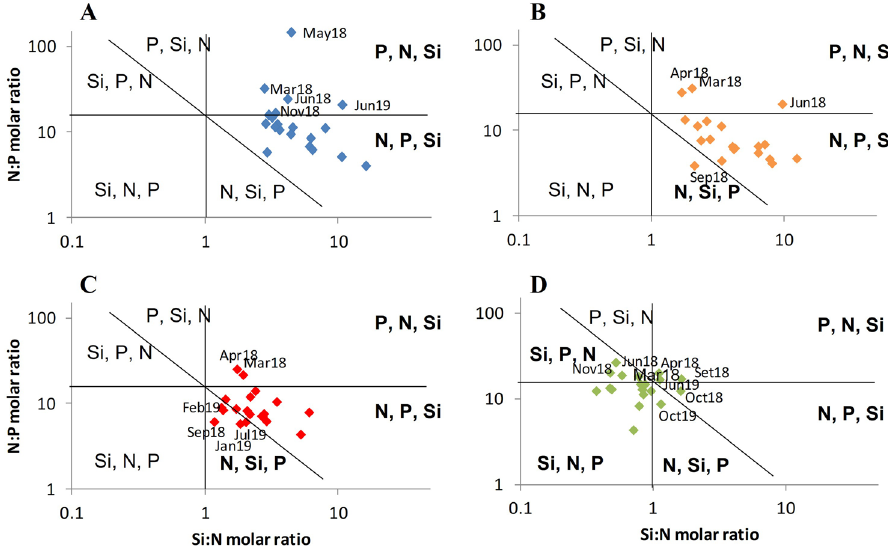
Figure 4. Si:N:P molar ratios in the Sado Estuary during sampling: ( A )—AC, ( B )—MC, ( C )—MR and ( D )— EM. Horizontal lines—N:P ratio 40 ; vertical lines—Si:N ratio 41 ; diagonal lines—aggregate ratio (Si:N:P = 16:16:1). These figures define six different areas characterized by the potentially limiting nutrients in order of priority 51 . The areas where this study samples are included are highlighted in bold.